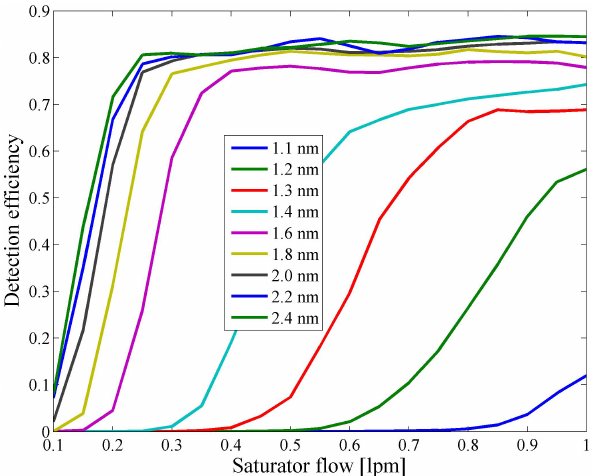
Figure 8. The detection efficiency of the nCNC for negatively charged particles formed during heating of ammonium sulfate, when the PSM was operated in laminar activation